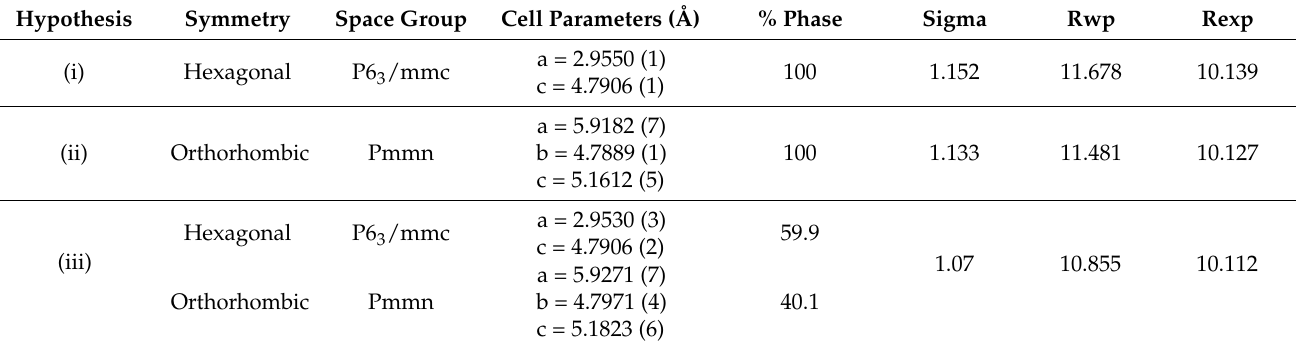
Table 4. Results of refinement of Ag 5 Sn 0.9